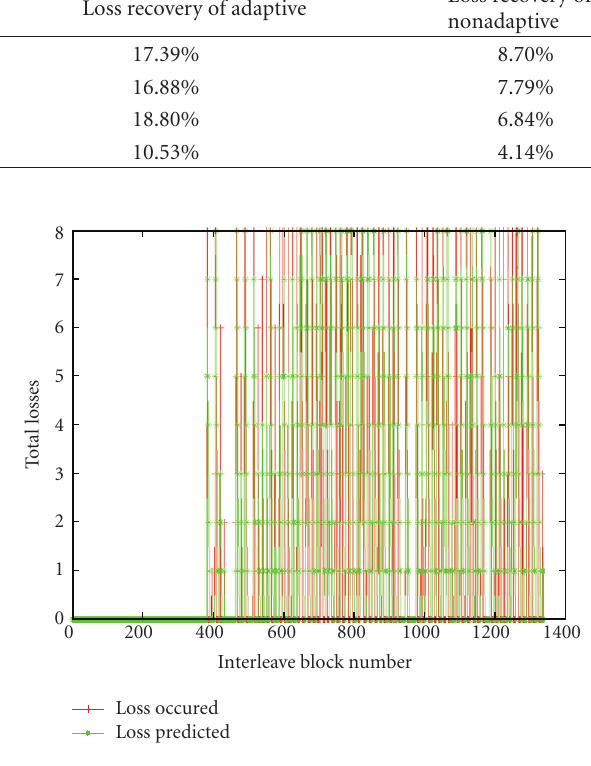
Figure 17: Performance of prediction for “ all ” sequence at 128 kbps, random delay 0.012, bu ff er size 500, packet size 256, span 8, PL rate